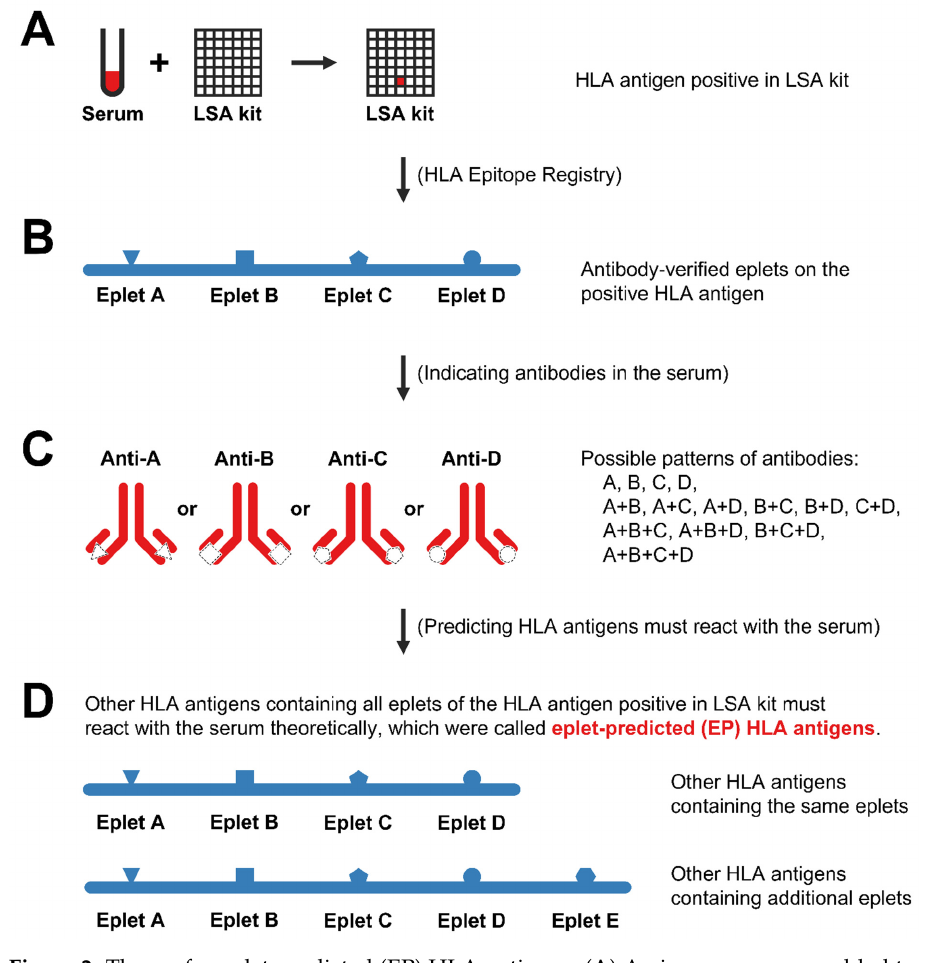
Figure 2. Theory for eplet-predicted (EP) HLA antigens. ( A ) A given serum was added to a LIFECODES Single Antigen (LSA) kit. Antibodies in the serum specifically bind to a bead embedded with single HLA antigens. The reactive HLA antigen was reported as positive. ( B ) Antibody-verified eplets of the positive HLA antigen were documented on the HLA Epitope Registry database. ( C ) As antibodies are eplet-specific, there must be antibodies in the serum that bind to at least one eplet of the positive HLA antigens. However, it is difficult to know the pattern of antibodies and determine which eplets the antibodies specifically react with in a clinical setting. ( D ) If other HLA antigens contain all eplets of the positive LSA antigen (containing either the same eplets or additional eplets), the serum containing antibodies that react with at least one eplet must theoretically react with these HLA antigens. These HLA antigens containing all eplets were called eplet-predicted antigens of the positive HLA antigens. In this way, we conservatively predicted the HLA antigens that must react with a given serum based on the result of LSA kits and eplets.